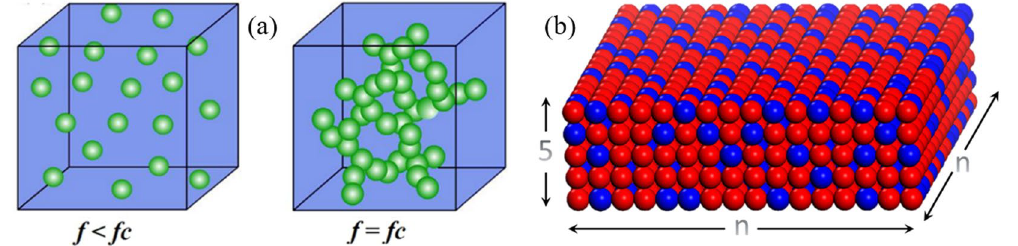
Figure 1. Sketch map of the distribution of two kinds of grains in a composite.